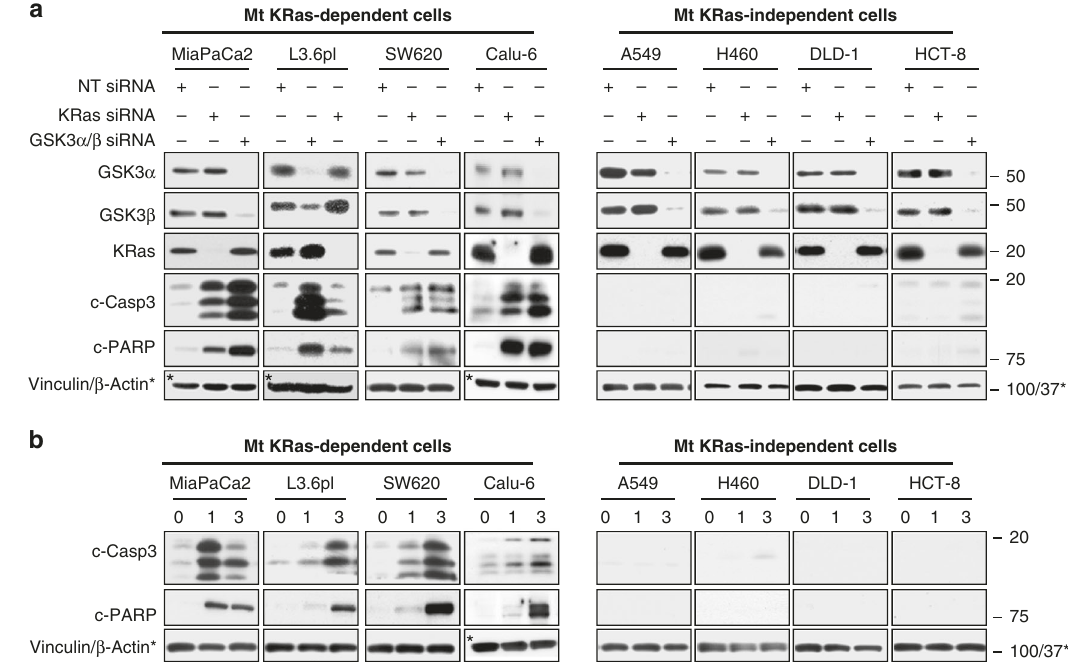
Fig. 2 Silencing of GSK3 α / β induces apoptosis only in mutant (Mt) KRas-dependent cancer cells. Mutant KRas-dependent (MiaPaCa2, L3.6pl, SW620, and Calu-6) and mutant KRas-independent (A549, H460, DLD-1, and HCT-8) human cancer cell lines were a transiently transfected with SMARTpool KRas, GSK3 α / β , or NT siRNAs or b treated with the GSK3 α / β inhibitor SB and processed 72 h later for western blotting for KRas, GSK3 α , GSK3 β , c-caspase-3, c- PARP, and Vinculin. For a and b , experiments were repeated at least three times for each cell